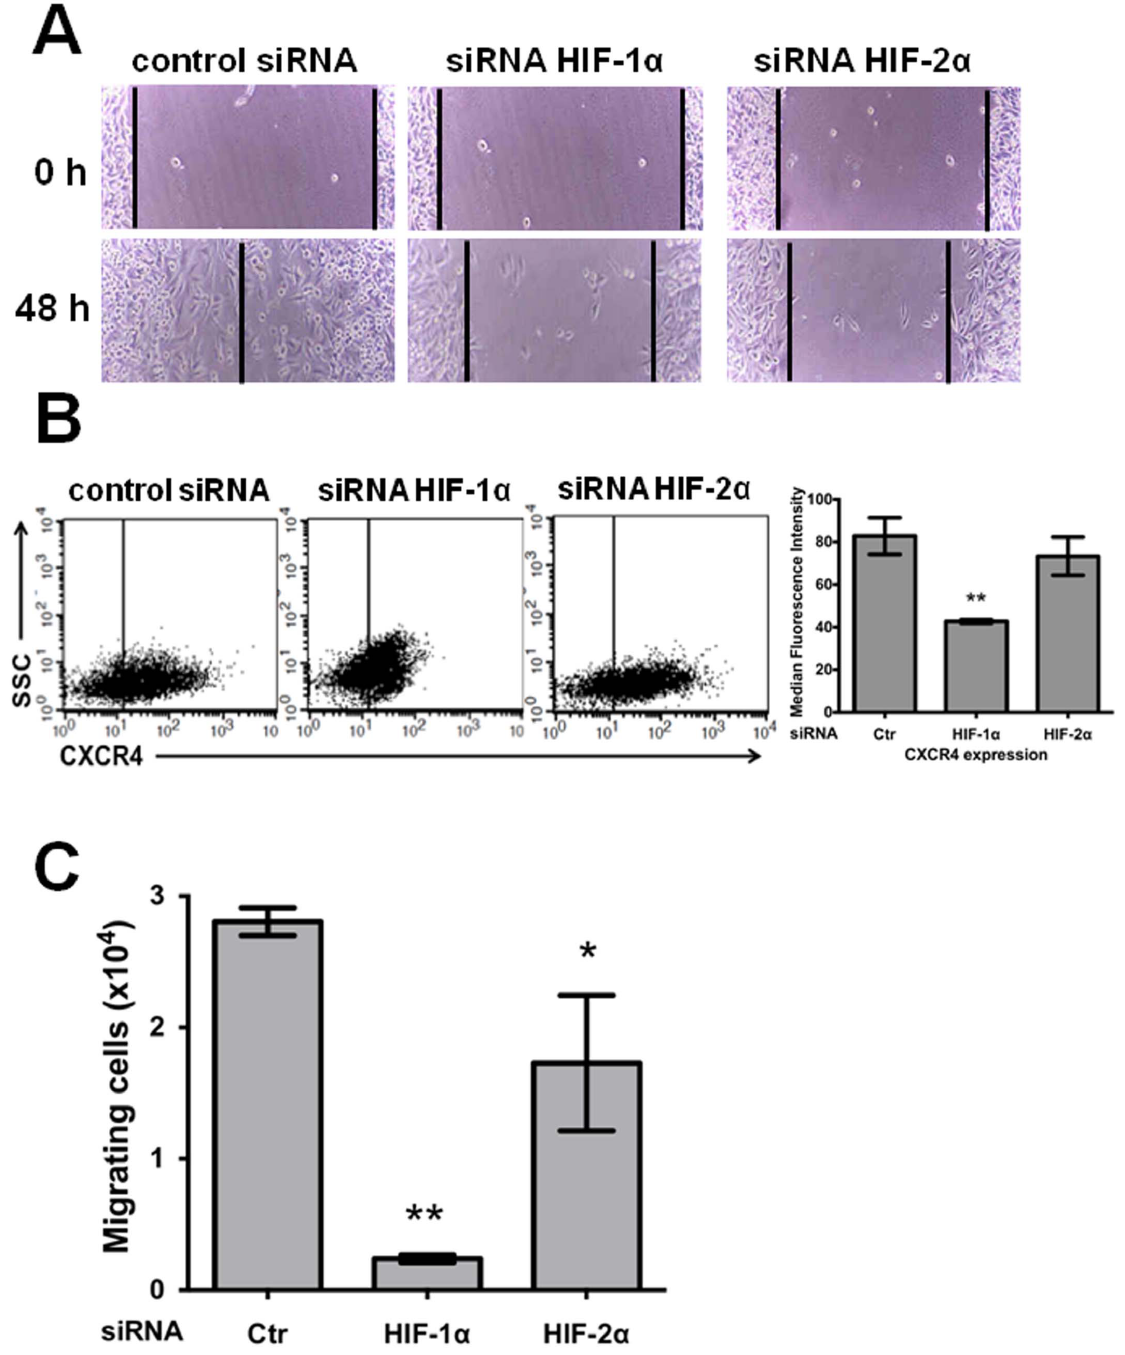
Figure 4. Stable knockdown of both HIF-1 a and HIF-2 a decreased the cell migration of SW480 cancer cells, but only HIF-1 a knockdown severely affected CXCR4-mediated chemotaxis. A) A wound-healing assay was used to determine whether cellular migration is dependent on either HIF-1 a or HIF-2 a expression. SW480 knockdown and control (scrambled shRNA plasmid) cells were grown to confluence on 24- well tissue culture plates, and the wound-healing assay was performed as described in the ‘‘Material and Methods’’. The scratched area was